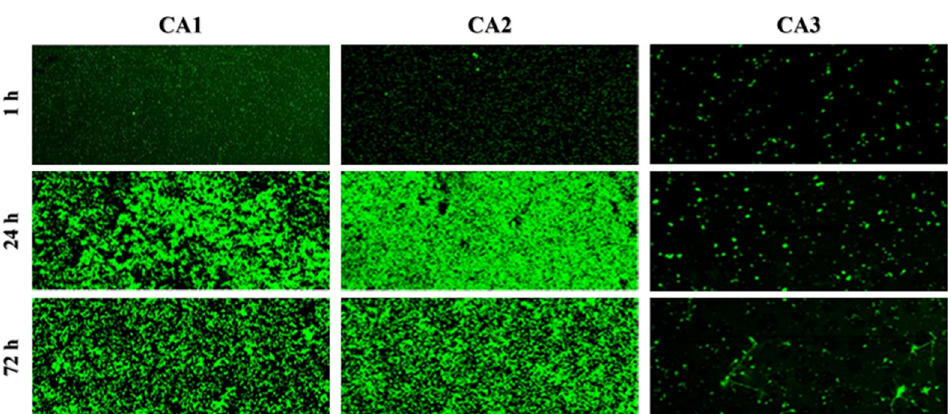
Figure 1. Two-dimensional scans of adhesion (1 h), early biofilm formation (24 h) and the mature biofilm (72 h) of C. albicans isolates (CA1, CA2, CA3) dyed with concanavalin A Alexa Fluor 488 conjugate (magnification × 50). The pictures of the CA1 and CA2 isolates are characterized by the presence of an increasing number of morphological forms in time, namely blastospores or true hyphae with sparse blastospores, respectively. The CA3 pictures at the three investigated time points are similar because the isolate proliferated only into the hypheal form, and the blastospores responsible for the “green image” in the CA1 and CA2 isolates were not present.